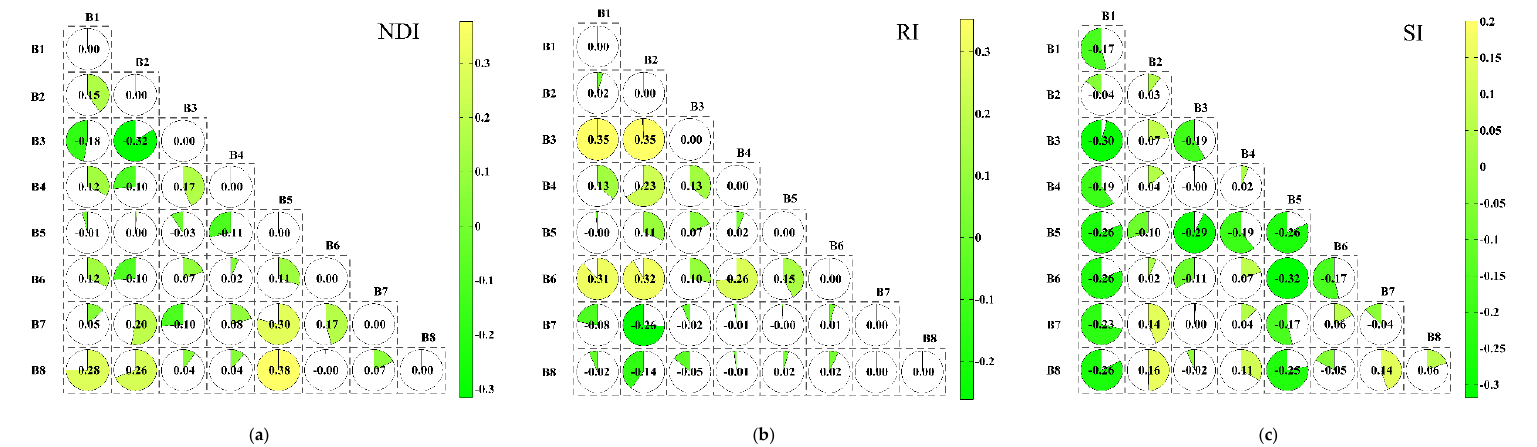
Figure 7. The correlation analysis between EC and optimized spectral indices based on second derivative (R-SD). ( a ), ( b ), ( c ) represent the correlation EC with NDI, RI, and SI, respectively.